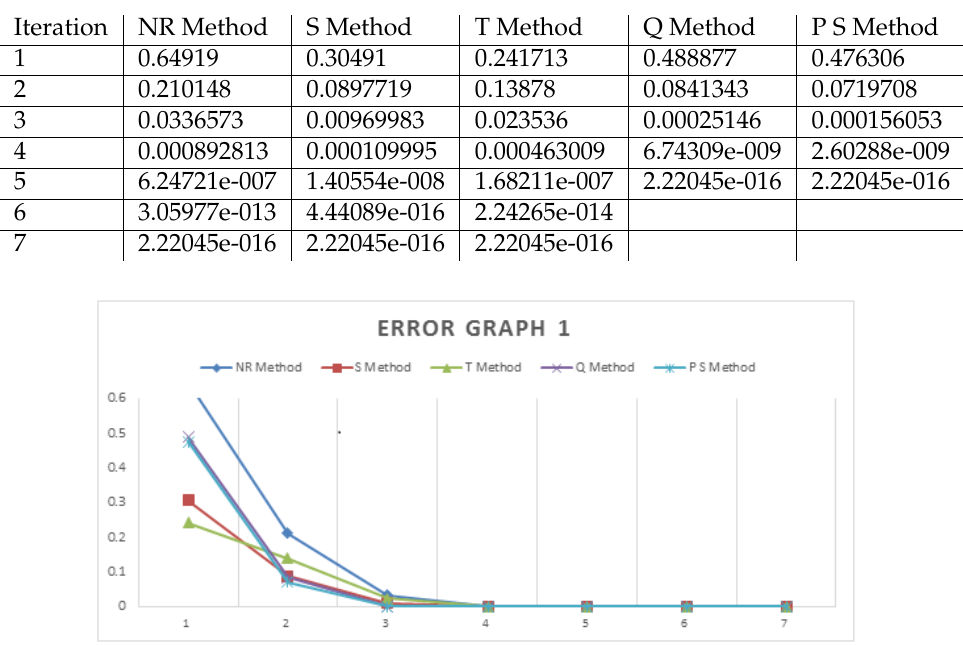
Table 2. Error analysis of NR Method, S Method, T Method, Q Method and P S Method for the Equation (18)